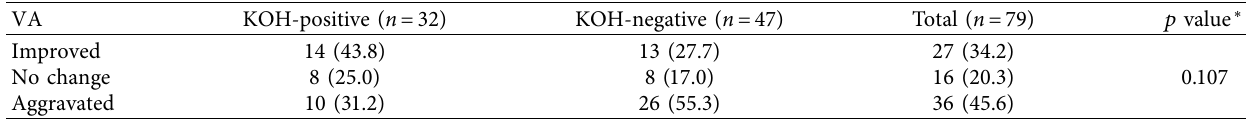
Table 4: Te change of visual acuity after treatment in eyes with culture-proven Fusarium keratitis divided by the initial KOH smear. VA